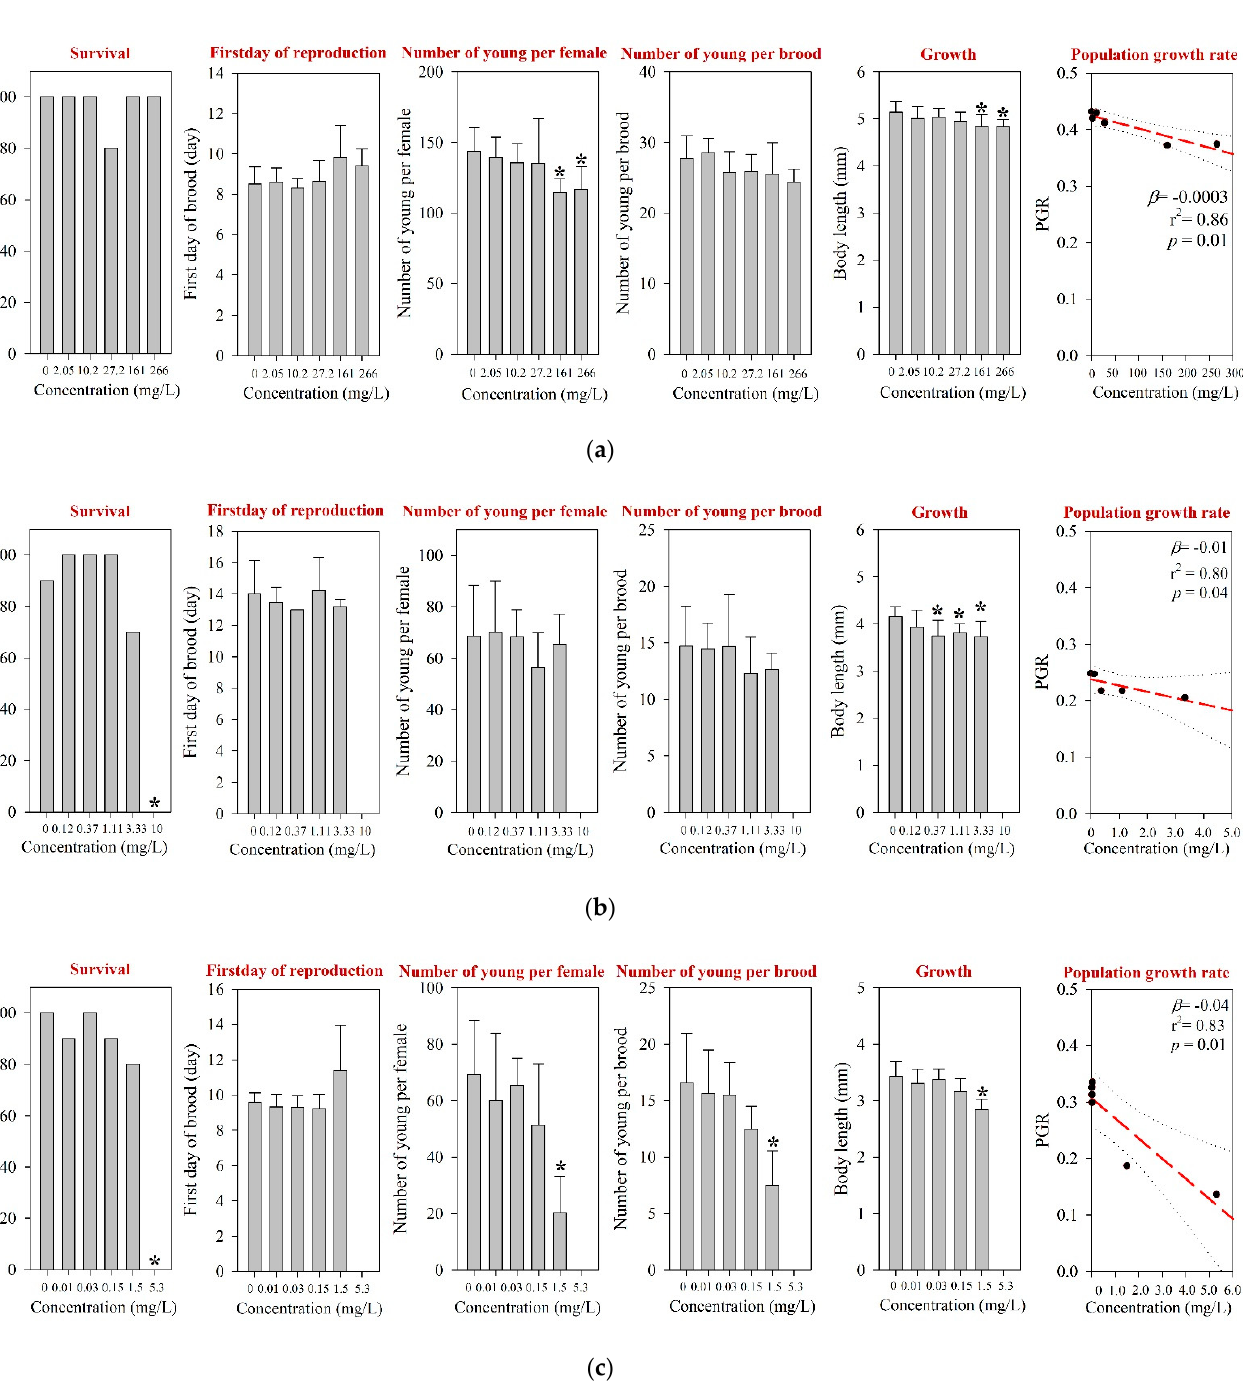
Figure 1. Results of the 21-d chronic D. magna test for ( a ) amoxicillin, ( b ) enrofloxacin, and ( c ) neomycin. The results are shown as mean ± standard deviation ( n = 10). The Asterisk (*) denotes a significant difference in the observation endpoint from that of the control ( p < 0.05). Monotonous trend was assumed for statistical analysis of the growth of D. magna following exposure to enrofloxacin ( b ). Nominal concentration was used for enrofloxacin ( b ). β , slope; r 2 , coefficient of determination; p , probability value.